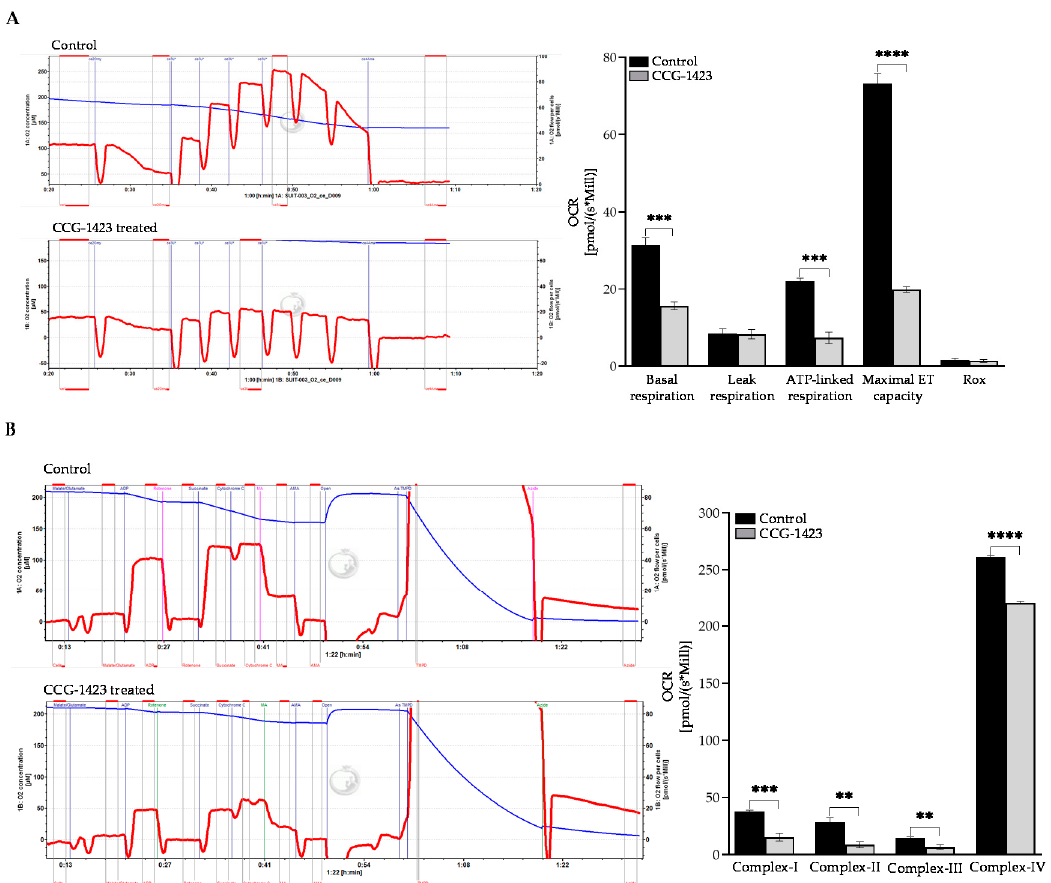
Figure 6. High-resolution respiratory analysis of oxidative phosphorylation. ( A ) OCR and basal respiration, leak respiration, ATP-linked respiration, Maximum ET capacity was analyzed using an Oroboros O2K instrument. Intact C2C12 cells were pre-treated with CCG-1423 with 10 μ M for 24 h treatment. OCR and other functional aspects indicated above in the figure were repressed. ( B ) C2C12 cells were permeabilized and were used to determine OCR levels at complexes of ETC. OCR at complex I–IV of ETC were repressed on the treatment of CCG-1423. ** p < 0.01, *** p < 0.001, **** p < 0.0001 ( n = 3).